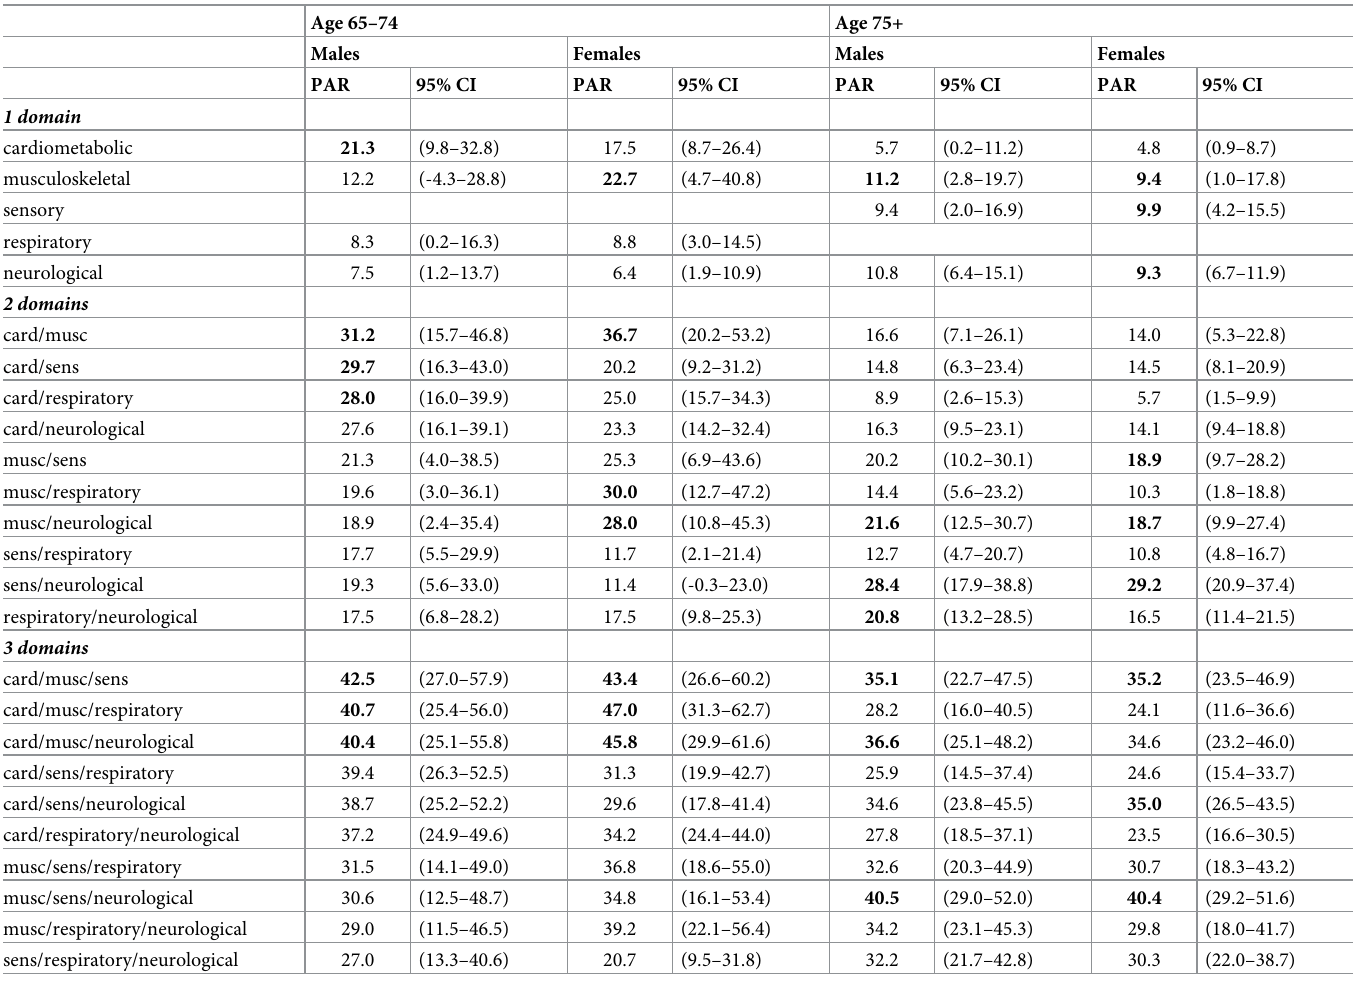
Table 4. Population attributable risk for activities of daily living disability by disease cluster after five years of follow up, stratified by age and sex ab